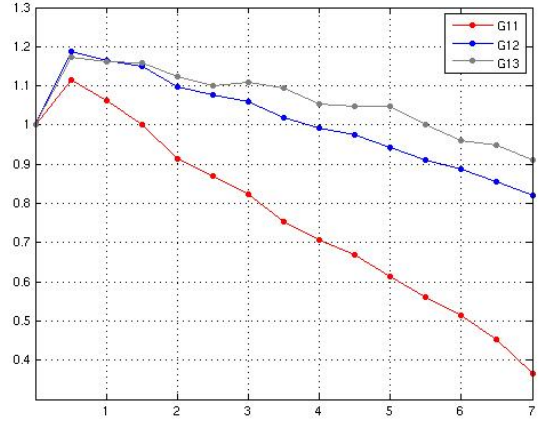
Fig. 9. Along-slope transport of the gravity current in the 3-D ex- periments during the first 7.5 days of the